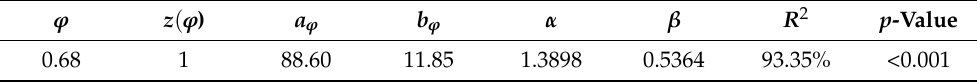
Table 3. Regression parameters’ values of Equation (9).